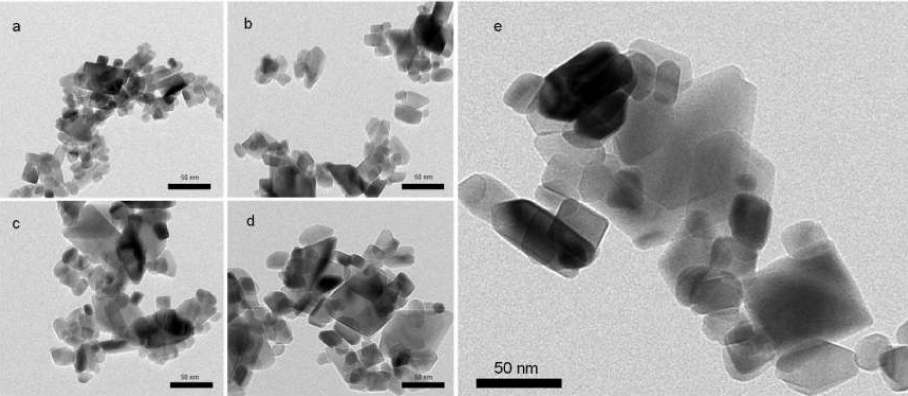
Figure 3. TEM images of TiO 2 NPs treated hydrothermally at 250 ◦ C for ( a ) 12 h, ( b ) 24 h, ( c ) 48 h, ( d ) 72 h and ( e ) at 310 ◦ C for 24 h. Scale bars: 50 nm.